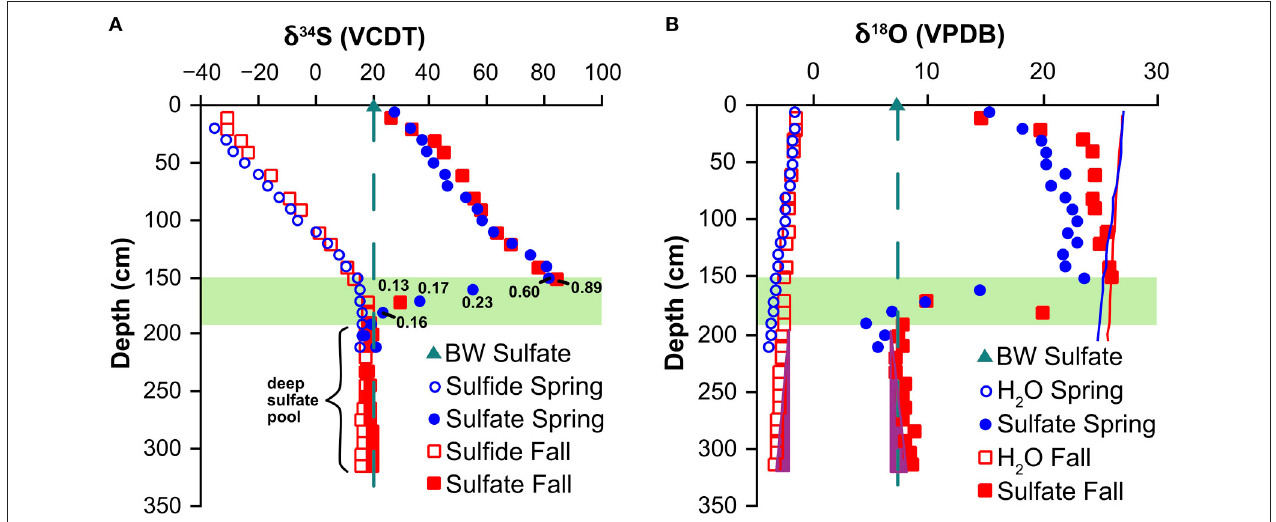
FIGURE 4 | (A) Sulfur and (B) oxygen isotope trends for sulfate, sulfide, and pore-water. The samples below a depth of 190cm are designated as “deep sulfate pool,” whereas samples in between a sediment depth of 150 and 190cm are considered to belong to the lower part of the SMT. The dark green triangle and dashed line represent the seawater sulfate isotope composition. The solid blue and red line (B) are the predicted sulfate-oxygen isotope composition at equilibrium with water calculated from Fritz et al. (1989). Purple triangles (B) indicate oxygen isotope trends for water and sulfate do not correlate. The green band represents the